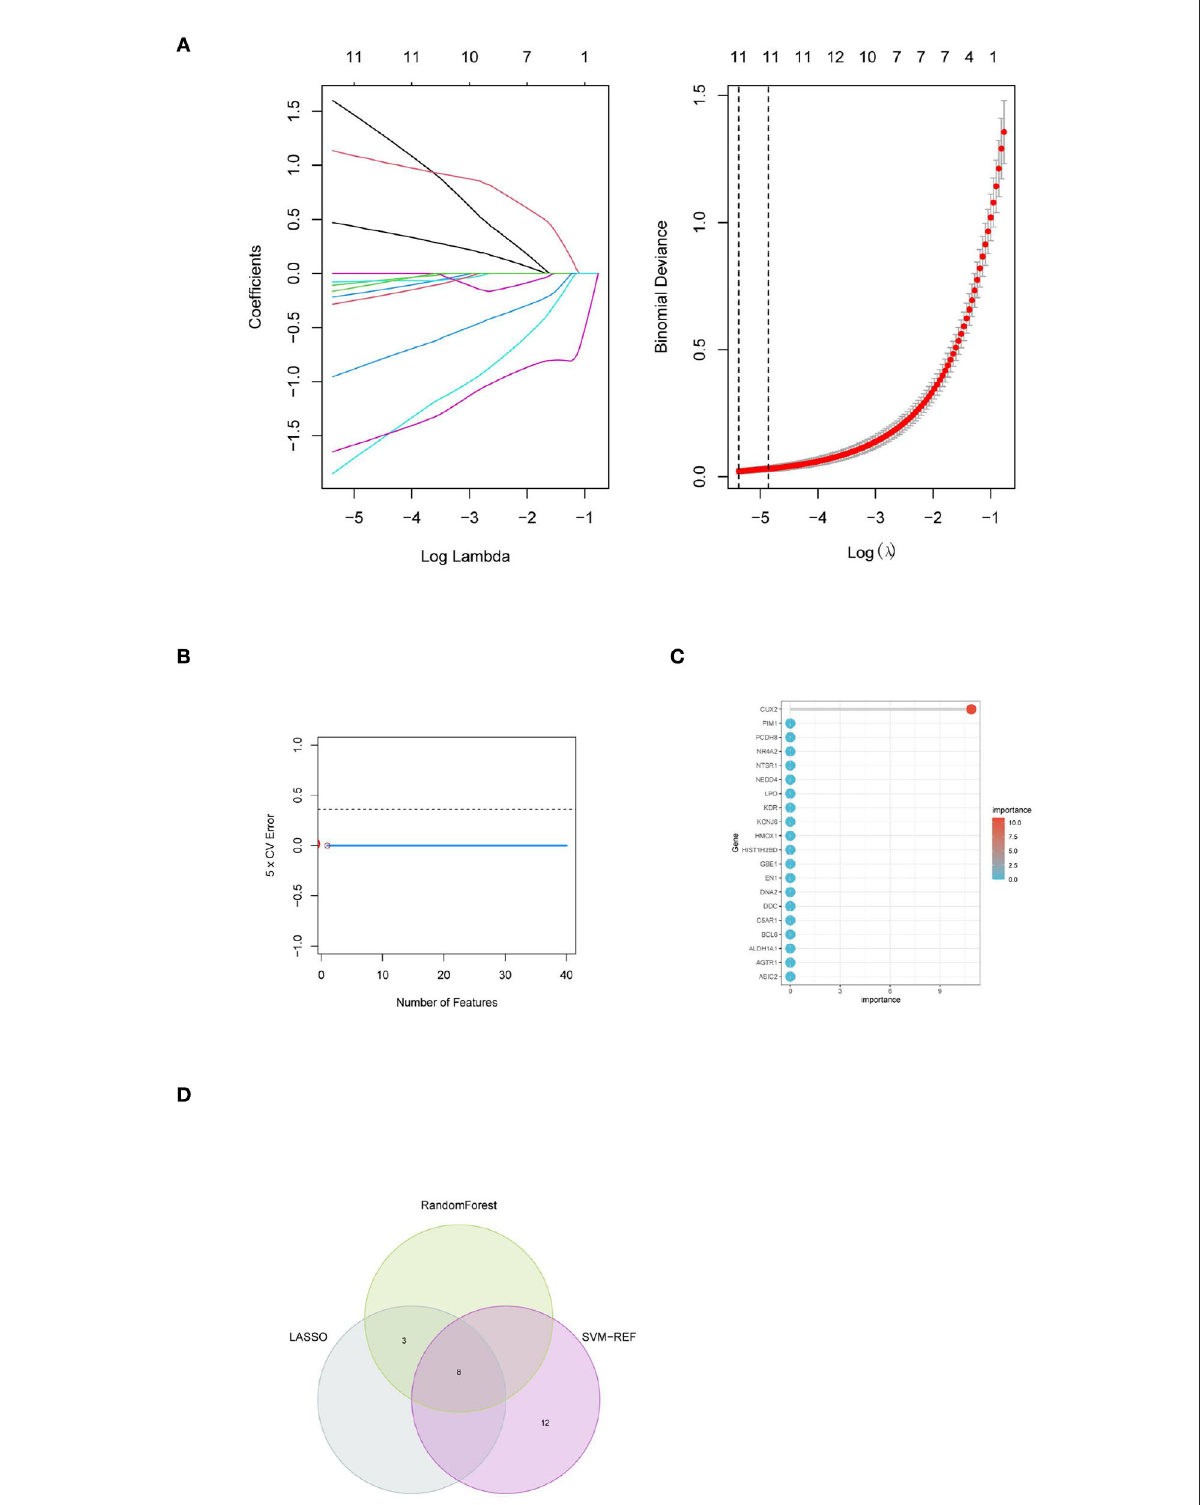
FIGURE4 Identification of hub genes for PD based on machine learning algorithms included (A) the Log (Lambda) value of the three genes in the LASSO model and the most proper log (Lambda) value in the LASSO model, (B) the optimum error rate of the SVM model based on one characteristic gene, (C) the RF module based on the top 20 genes, and (D) the Venn diagram showing the overlapping genes in LASSO, SVM, and RF